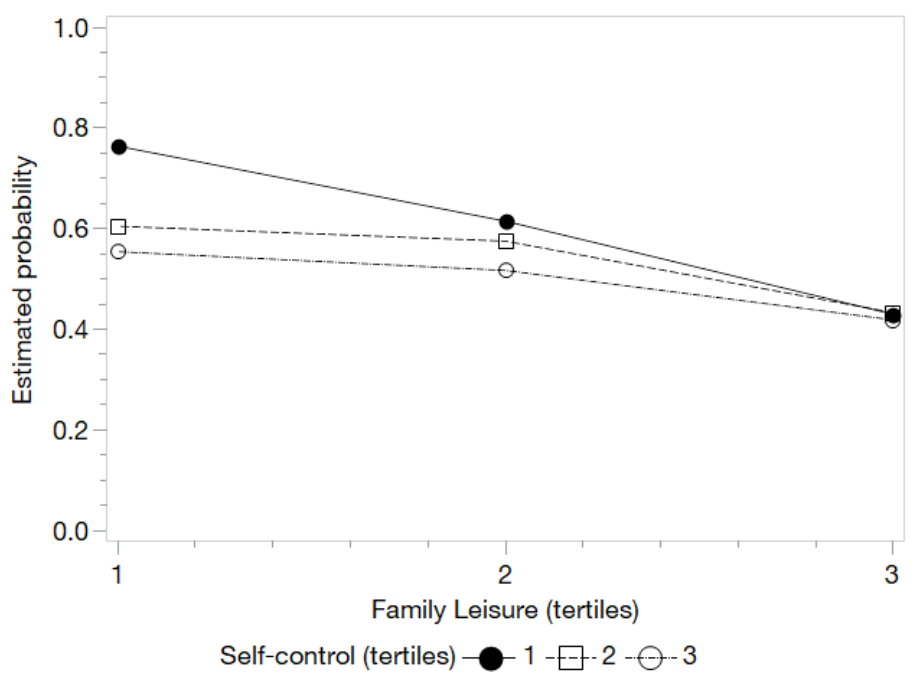
Figure 2. Estimated probabilities for the interaction between self-control and family leisure for the YAU in the Netherlands.